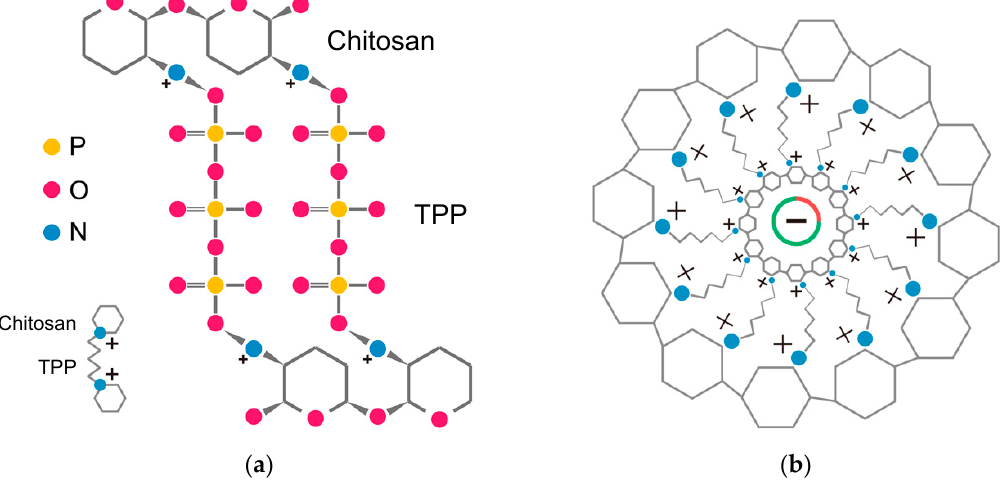
Figure 3. Molecular structure and electrostatic interactions of chitosan–tripolyphosphate (TPP) ( a ), and chitosan–TPP–plasmid DNA nanoparticles ( b ).